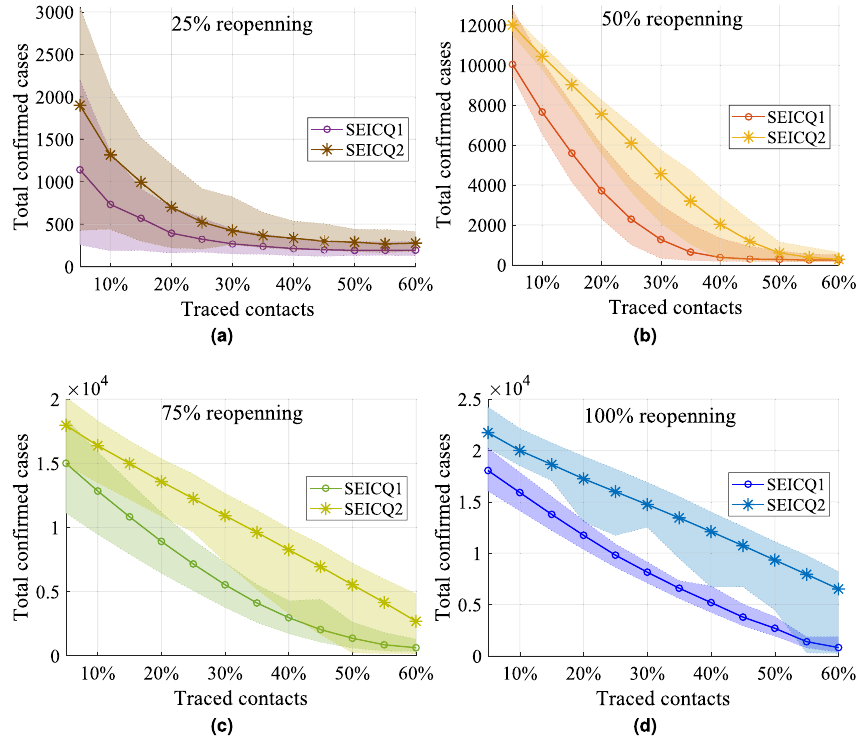
Figure 6. Impact of contact tracing. Total reported cases in eight months after ‘Stay-At-Home order’ lifted for different movement restrictions scenarios. Contact tracing is applied after May 4, 2020. This figure is showing the median (solid lines) and interquartile range (shaded regions) value of 1000 stochastic realizations.